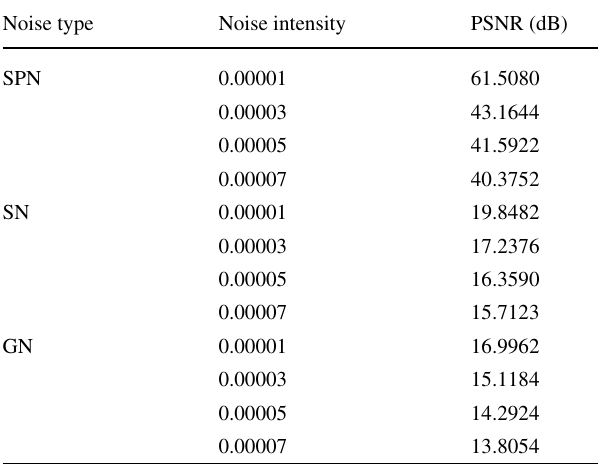
Table 10 The PSNR values of the plaintext images and decrypted images with